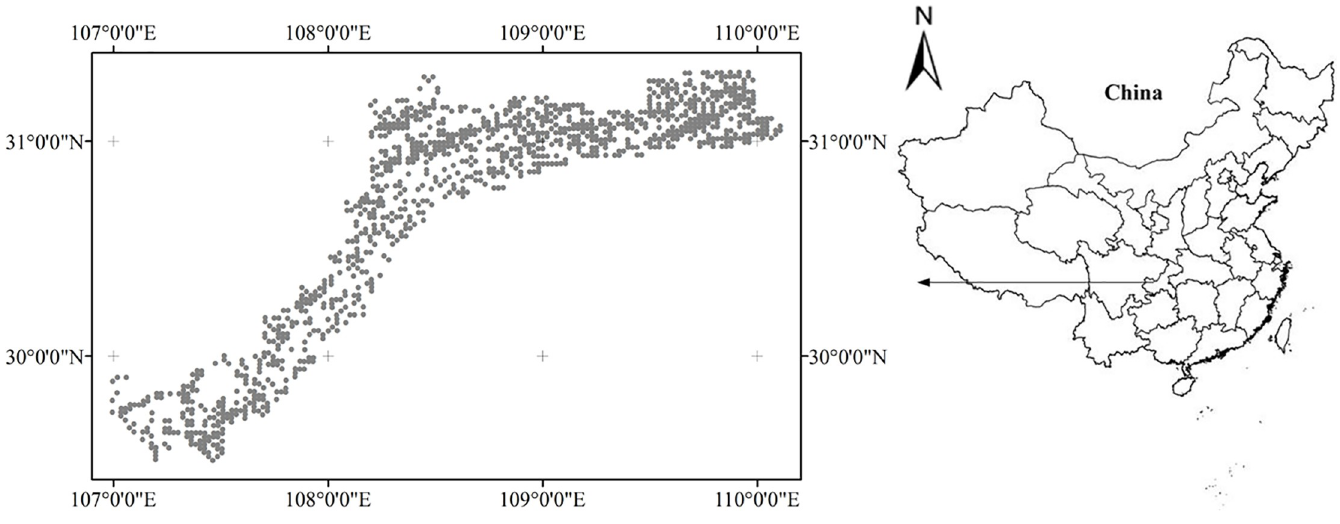
Fig 1. Maps of study area location and sample